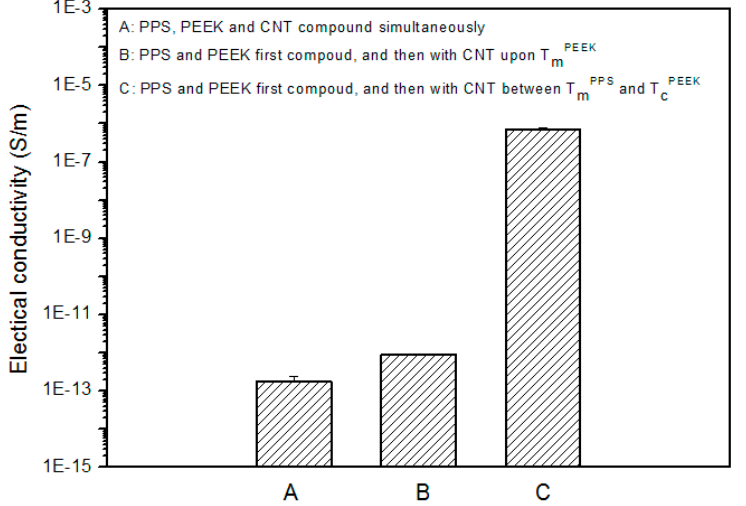
Figure 2. Electrical conductivity of PPS/PEEK/MWCNT nanocomposites containing 1 wt %